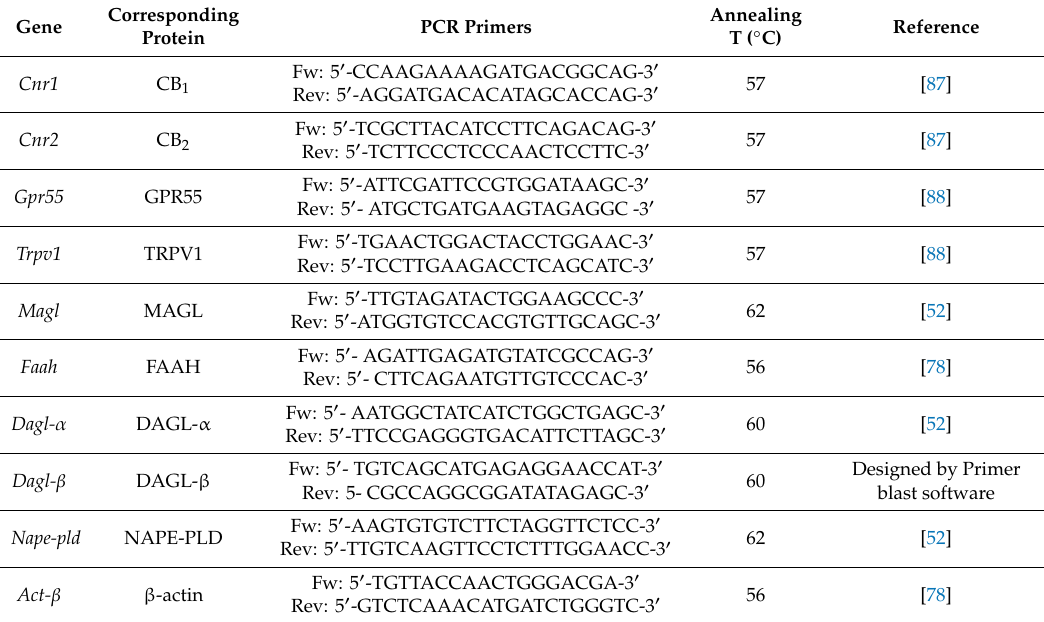
Table 1. List of the primers used for qRT-PCR